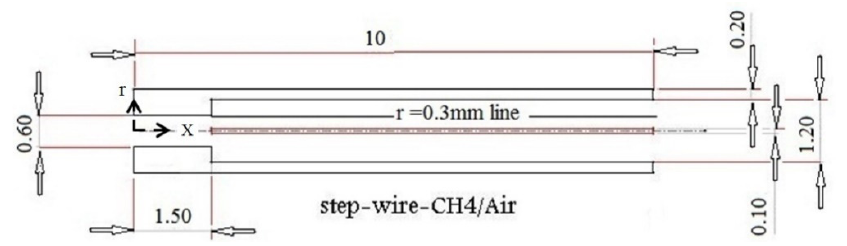
Figure 1. The geometry of the studied micro-burner (dimensions in “mm”) [8]. Table 1. Some of the applied values in the study.